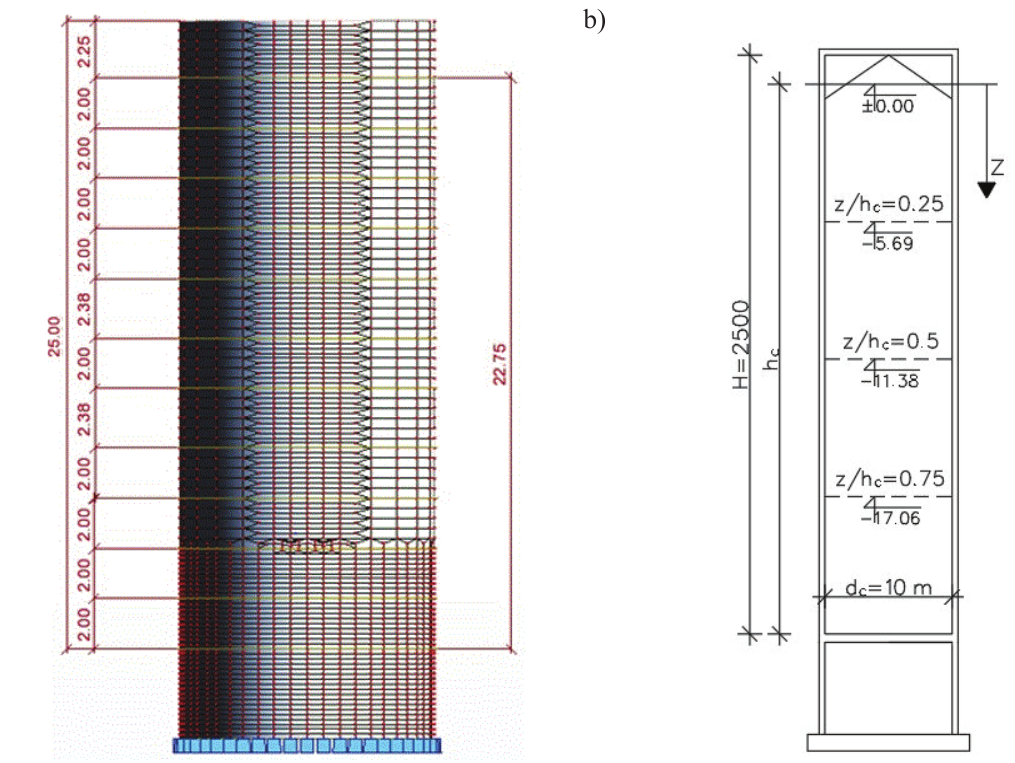
= 10 m: a) model of the chamber using the finite c